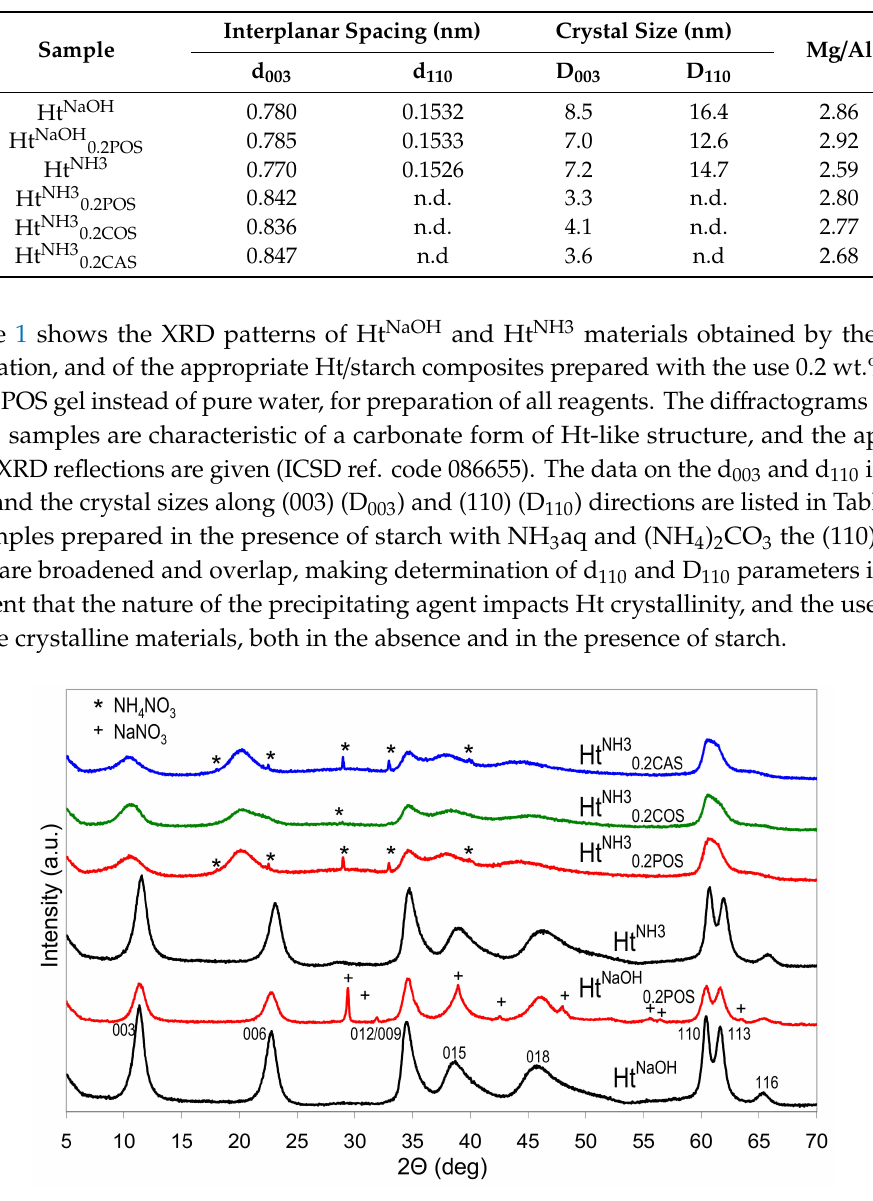
Figure 1. X-ray di ff raction (XRD) patterns of Ht materials obtained with the use of di ff erent precipitating agents and in the presence or absence of various